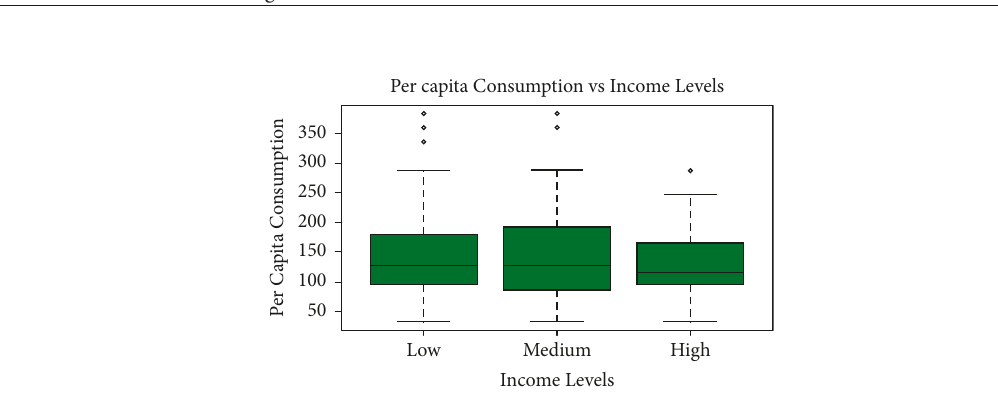
Figure 2: Box-plot of per capita charcoal consumption ( y -axis in kg/person per year in the three main income samples ( x -axis in TZS per year)).